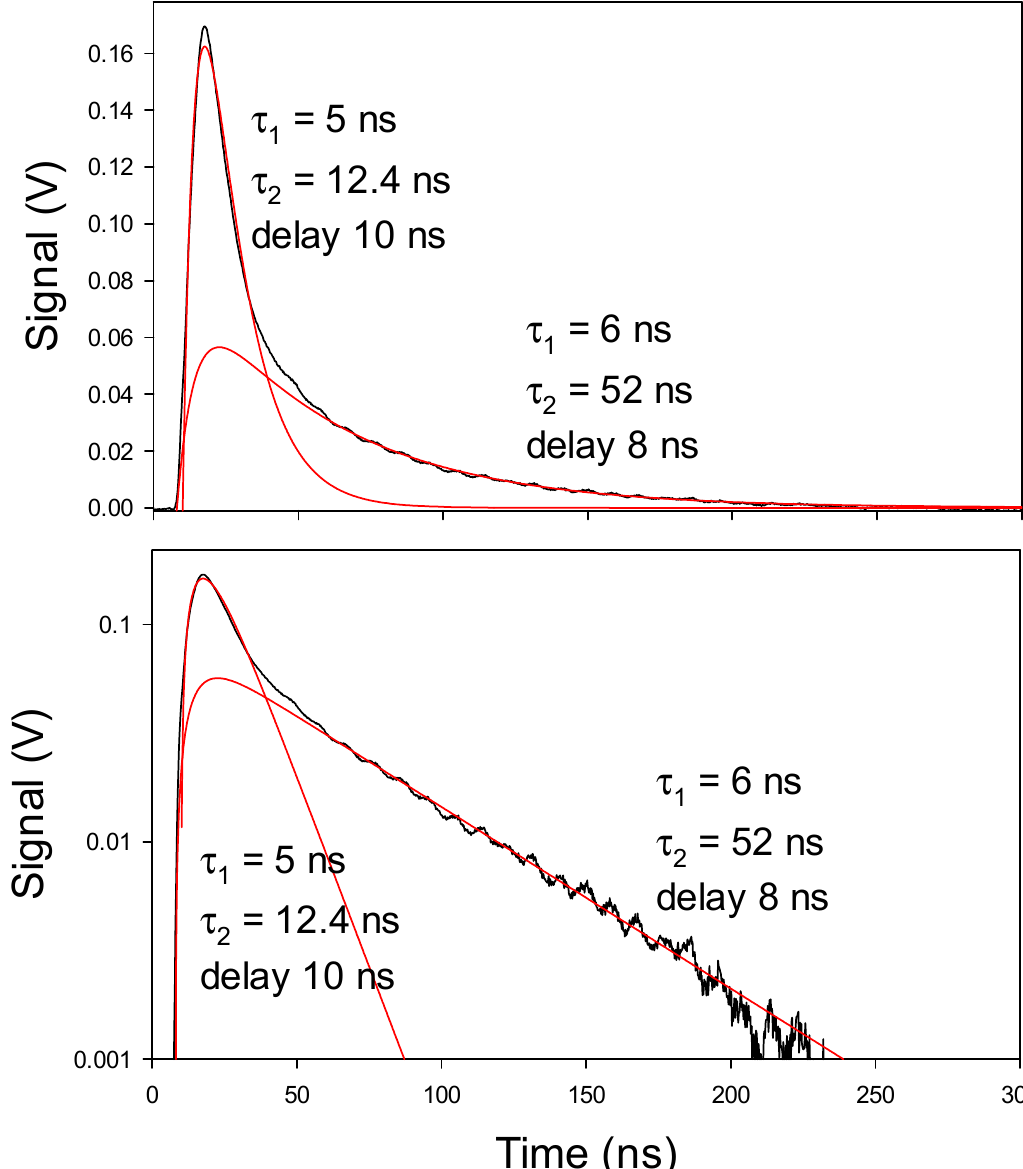
Figure 2. Linear and logarithmic plots of the same data with overlapping time constants for charged and long-lived neutral kaons. D(0) formed with 0.2 mbar D 2 in chamber, collector at 94 cm, 0 V bias, 0.4 J, 10 Hz pulse repetition, 1064 nm light. A small background signal still remaining with 2 mbar D 2 pressure is subtracted, in this way decreasing the signal due to neutral kaon oscillations at long times. The red curves are calculated using Equation (3) with time constants shown.